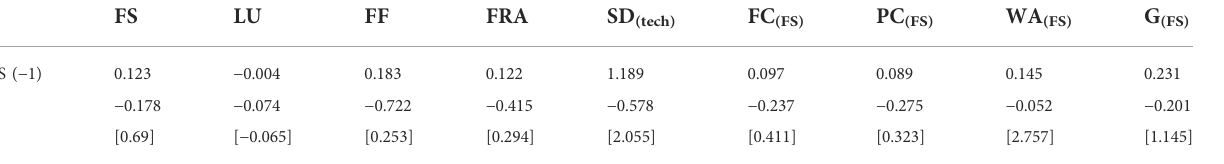
TABLE 7 Vector auto-regressive